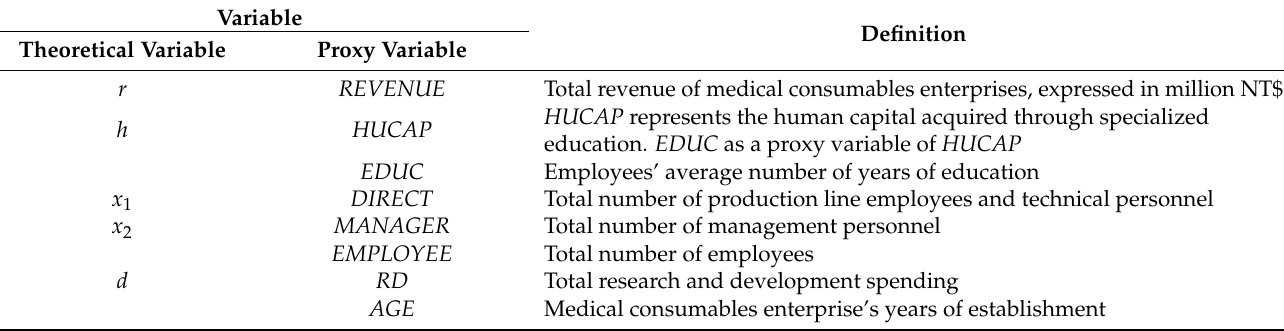
Table 2. Variable